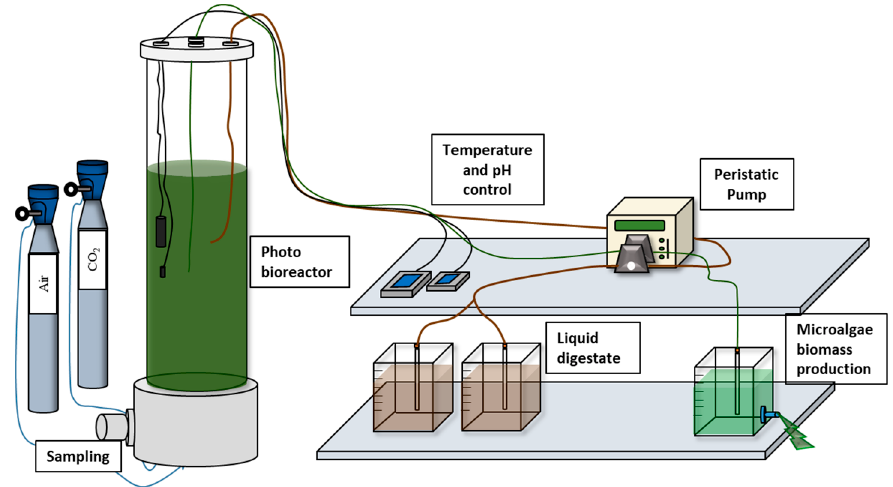
Figure 1. Scheme of experimental set up for microalgae production in semi-continuous mode in outdoor conditions in the vertical closed photobioreactors.